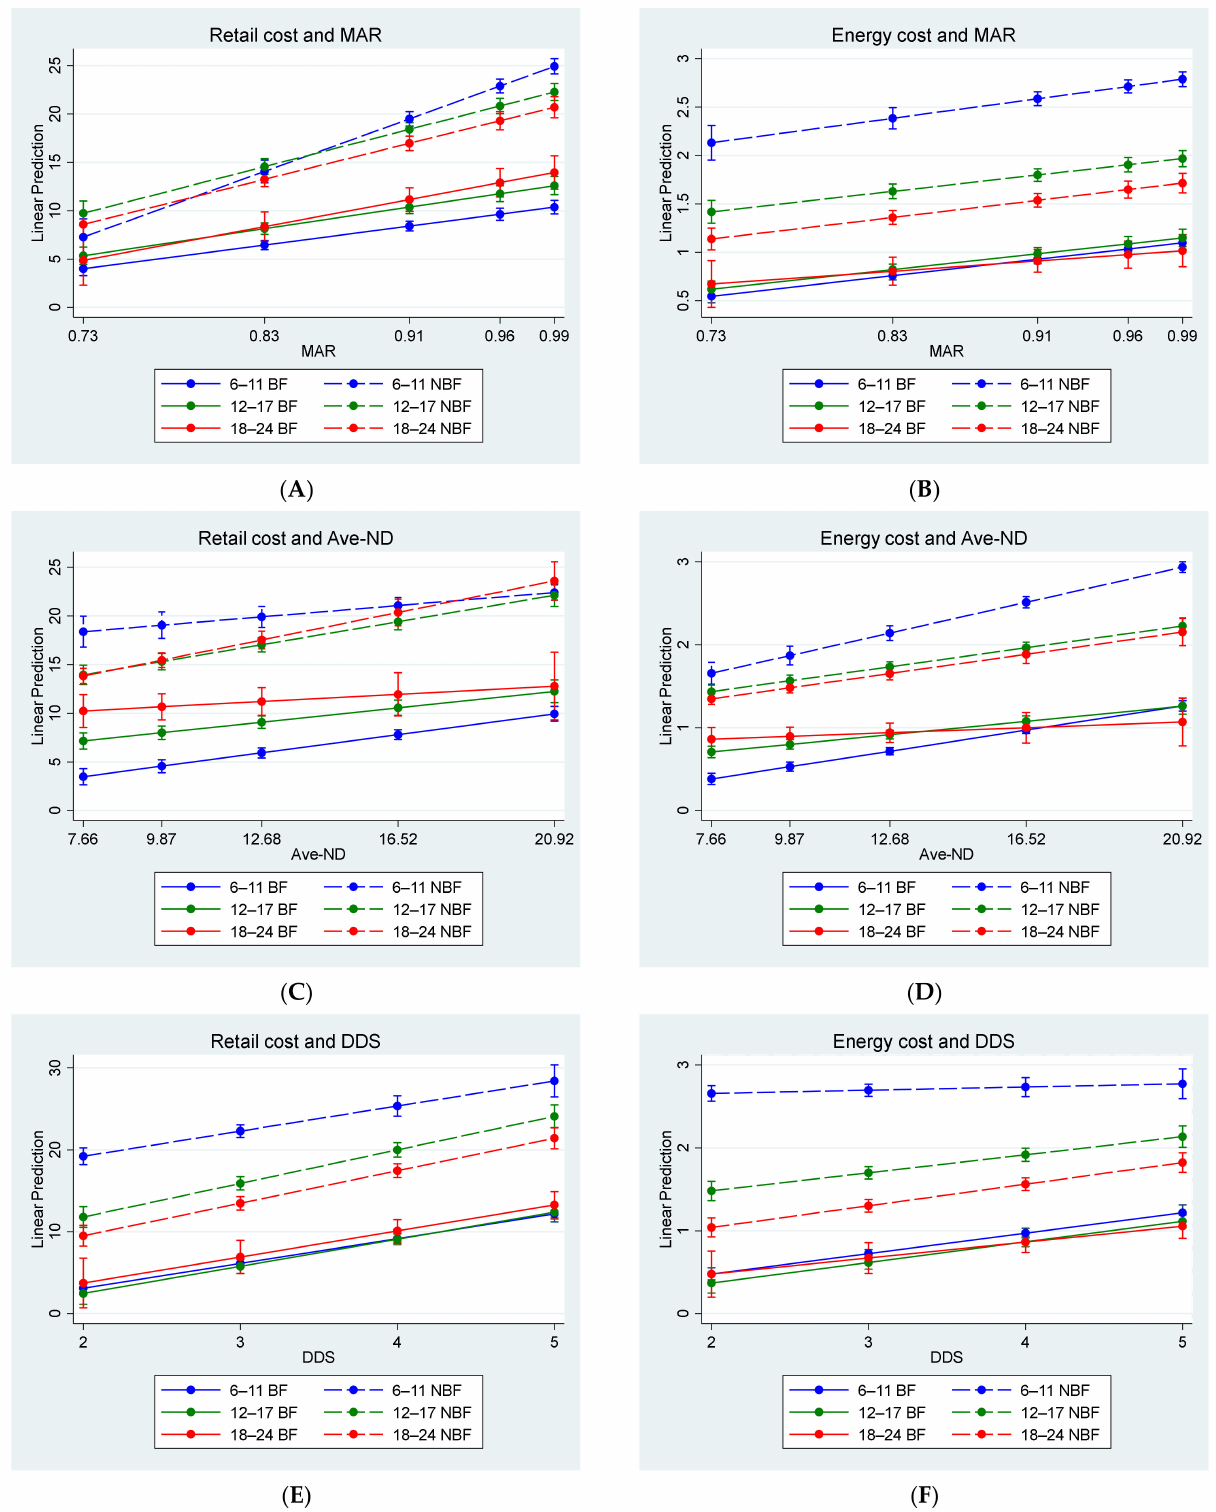
Figure 2. Adjusted predictions and 95% CI for retail cost and energy cost with diet quality. ( A ). Retail cost and mean adequacy ratio (MAR). ( B ). Energy cost and mean adequacy ratio (MAR). ( C ). Retail cost and average nutrient density (Ave-ND). ( D ). Energy cost and average nutrient density (Ave-ND). ( E ). Retail cost and dietary diversity score (DDS). ( F ) Energy cost and dietary diversity score